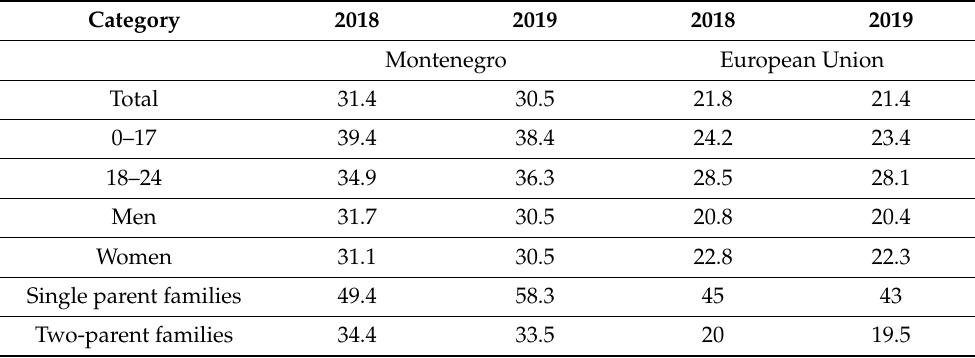
Table 1. Risk of poverty or social exclusion in Montenegro and the European